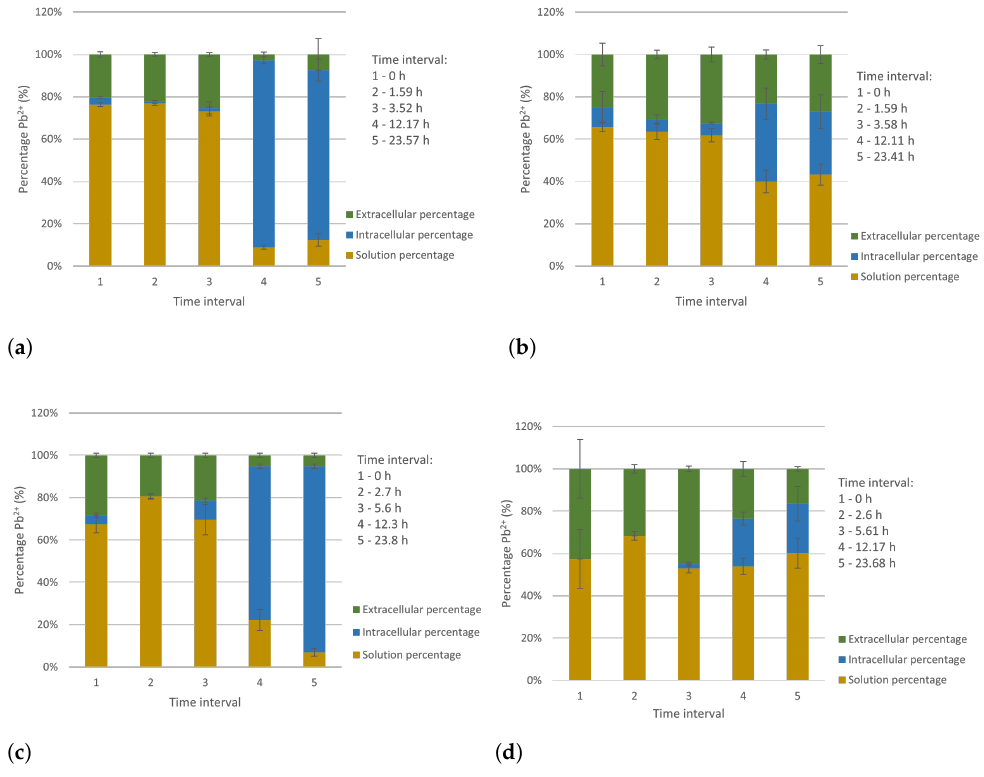
Figure 9. The percentage composition of the samples in terms of extracellular, intracellular and solution Pb(II) for ( a ) 80 mg L − 1 initial concentration Pb(II) with P. bifermentans , ( b ) 250 mg L − 1 initial concentration Pb(II) with P. bifermentans , ( c ) 80 mg L − 1 initial concentration Pb(II) with K. pneumoniae and ( d ) 250 mg L − 1 initial concentration Pb(II) with K. pneumoniae